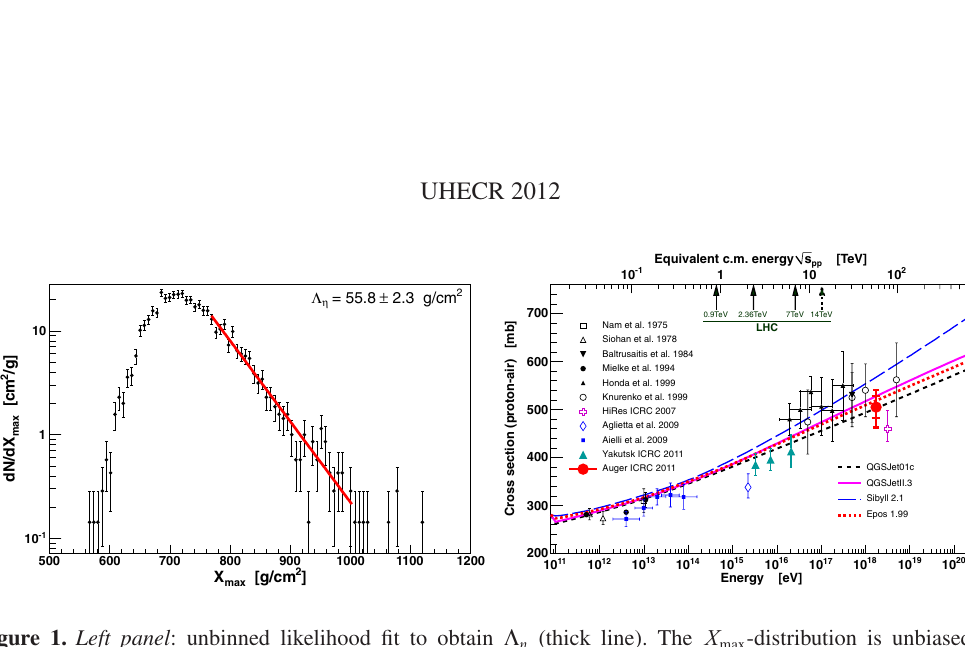
compared to other air